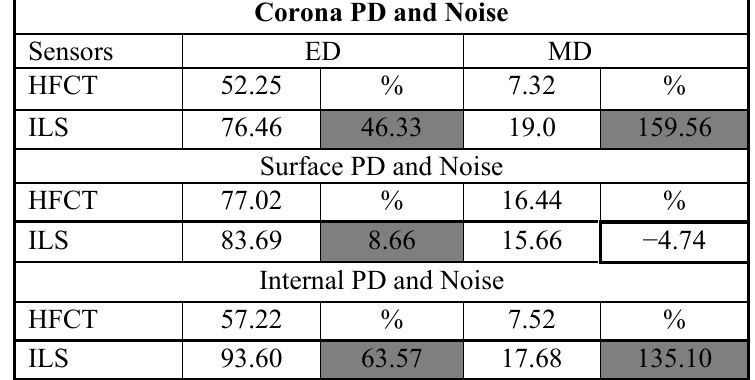
Table 3. MD and ED between clusters obtained with the two sensors for the intervals PRL [10, 30] MHz and PRH [30, 50]